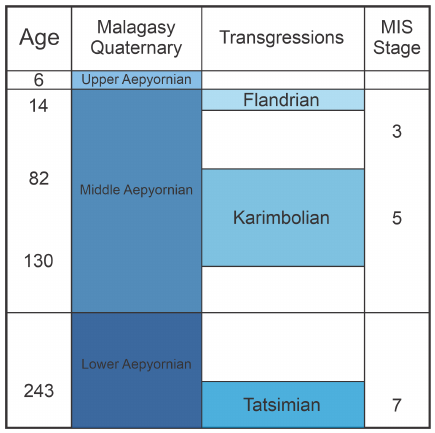
Figure 1. Malagasy Quaternary nomenclature (age is in ka; scheme modified after Battistini,